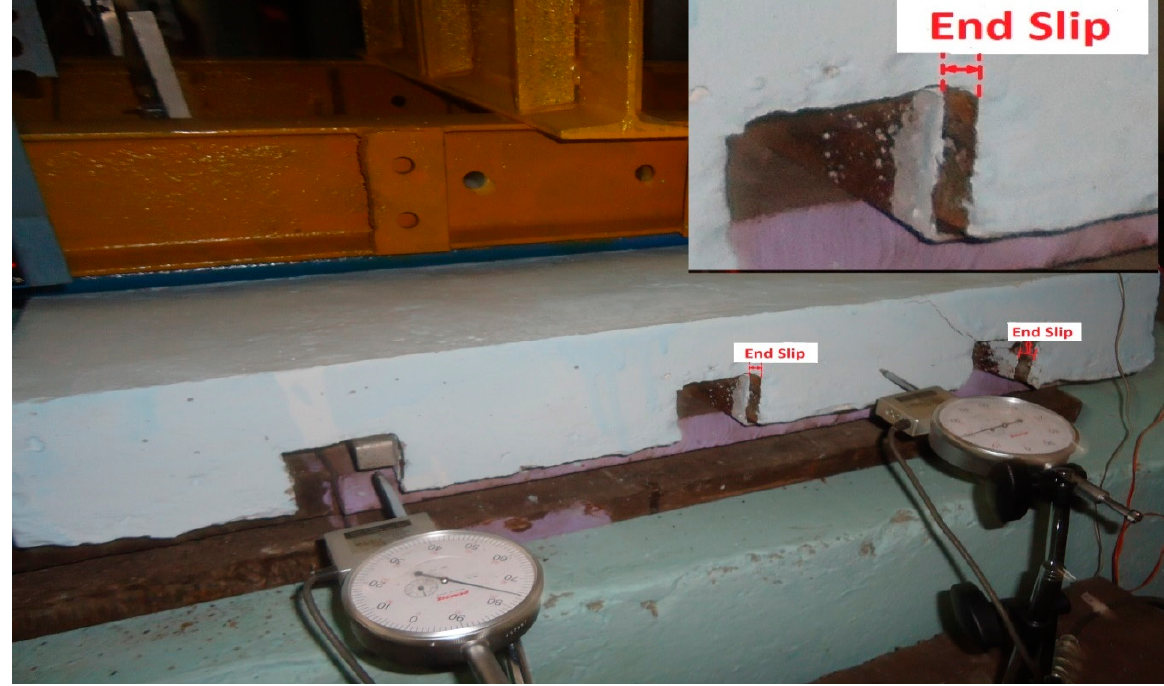
Figure 11. Slip of rectangular profiled composite slab.